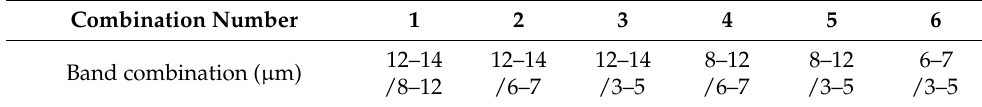
Table 1. The band combination number.